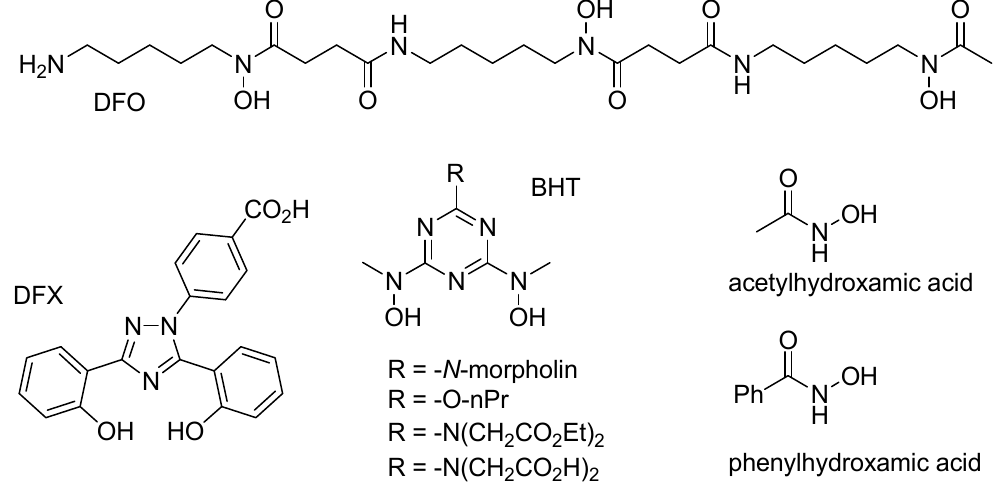
Figure 7. Structures of specific iron(III) chelators.